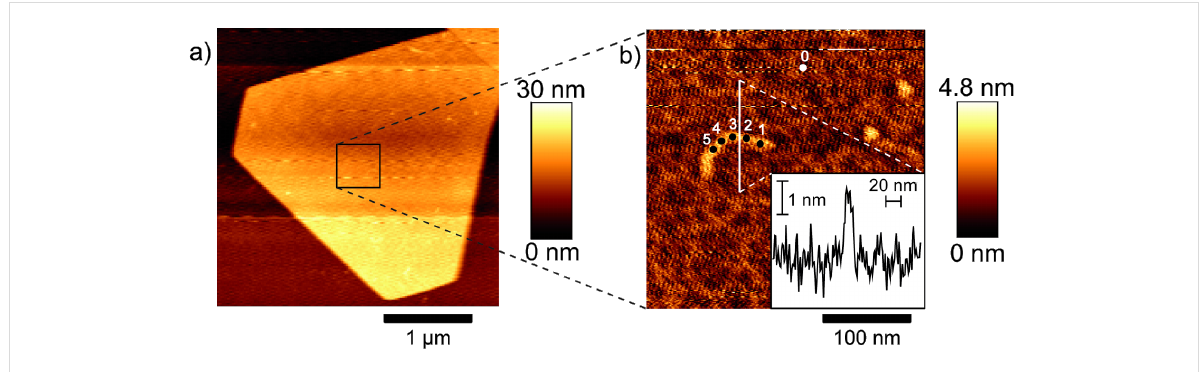
Figure 3: a) AFM topography image of a gold nanoplate with immobilized polyuracil strands, b) single strand of uracil homopolymer in the magnified area indicated in a). Inset in b) is the cross section corresponding to the line indicated in b).